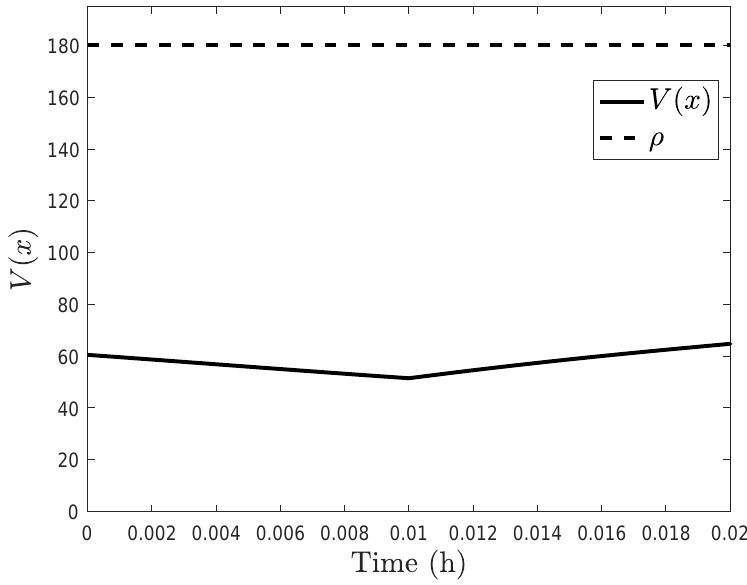
Figure 18. V ( x ) throughout the first sampling period with input rate of change